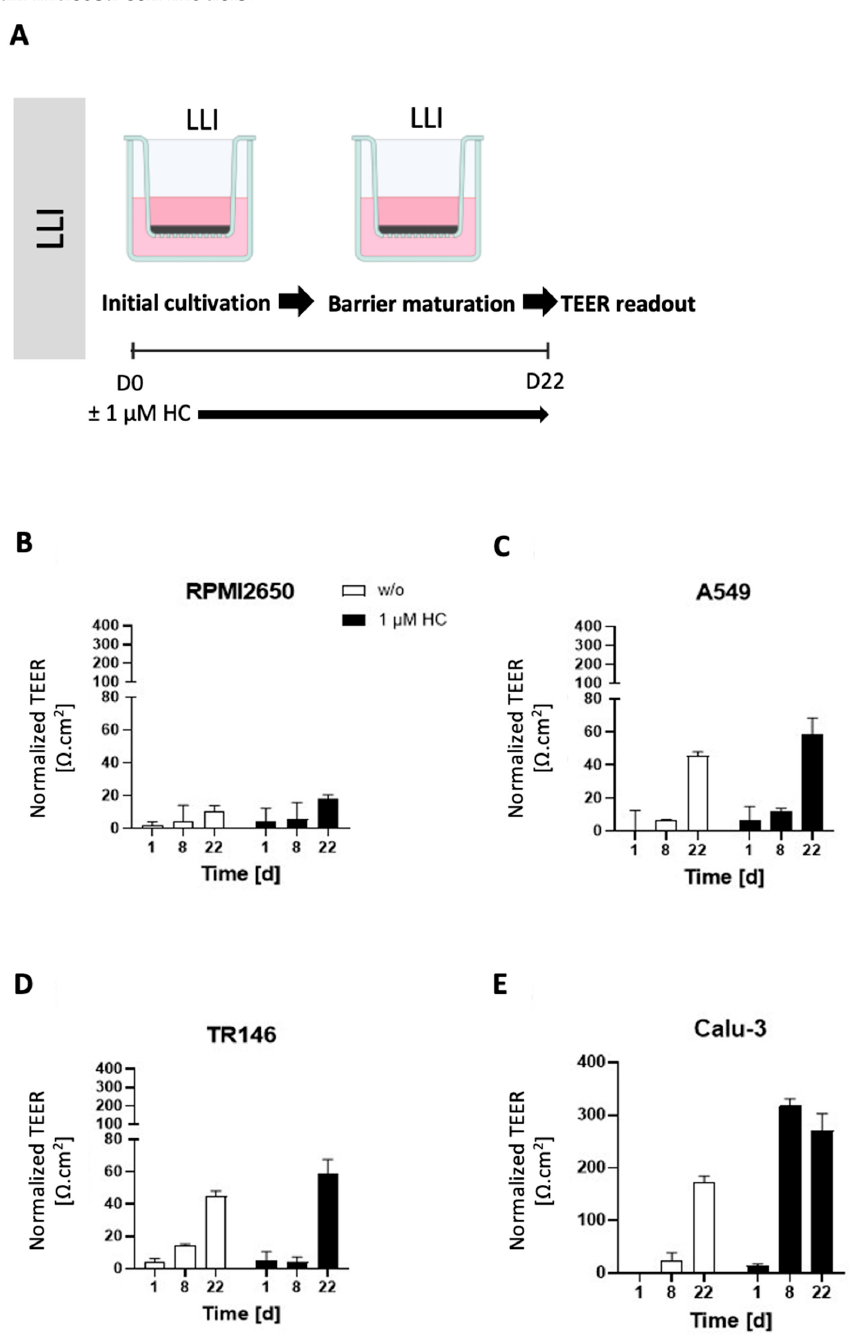
Figure 2. Effect of hydrocortisone (HC) on TEER-based read-out of barrier maturation dynamics of mucosa cells grown at confluency on porous membrane inserts throughout 22 days of liquid-liquid interface (LLI) culture. ( A ) Graphical visualization of the cultivation and treatment protocol, and normalized time-resolved TEER analysis of ( B ) RPMI2650, ( C ) A549, ( D ) TR146, and ( E ) Calu-3. Data are expressed as mean ± standard deviation for n = 3 replicates.